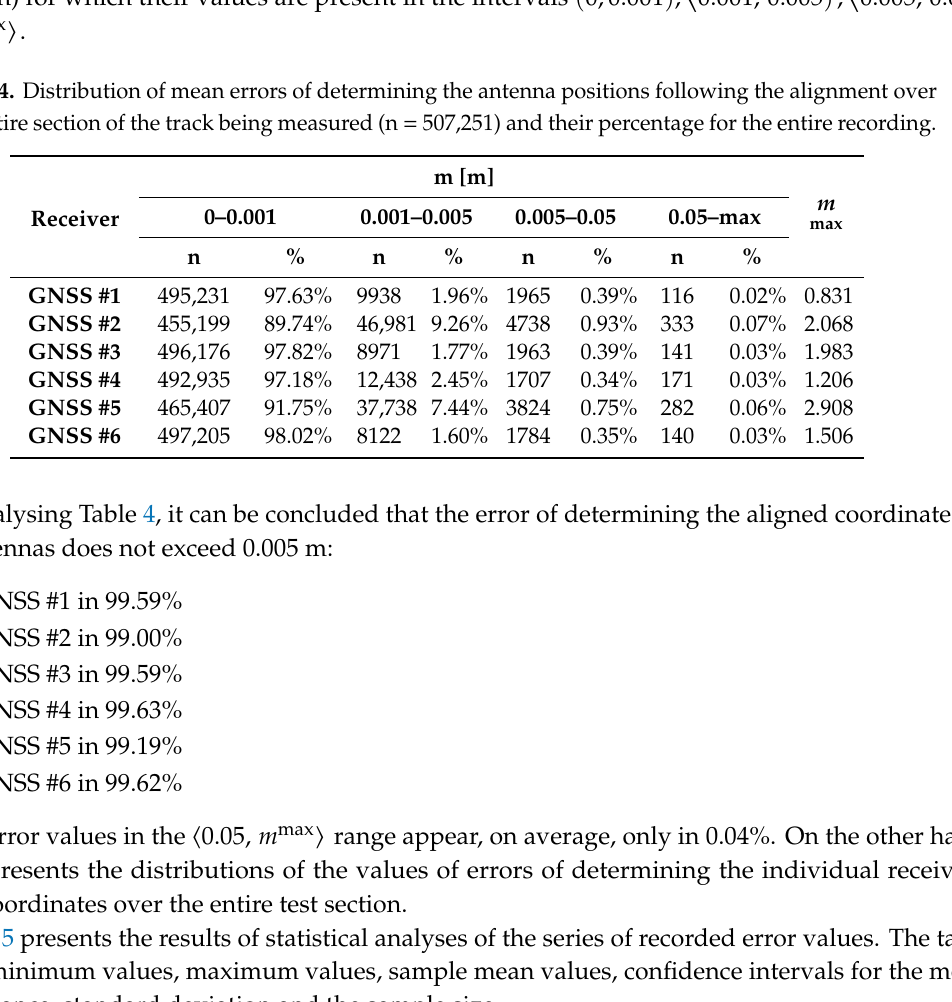
Table 4. Distribution of mean errors of determining the antenna positions following the alignment over the entire section of the track being measured (n = 507,251) and their percentage for the entire recording. m [m] Receiver % GNSS